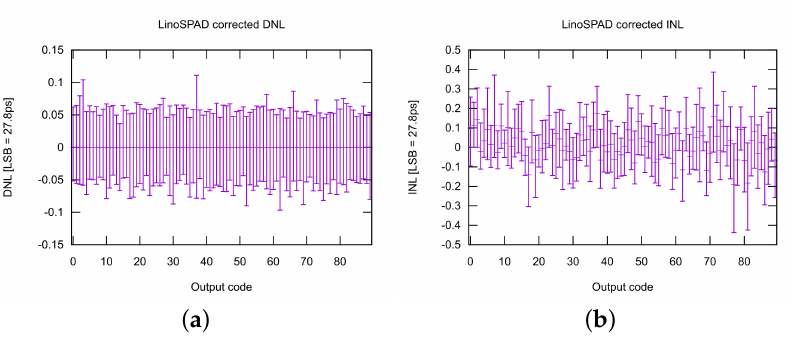
Figure 11. DNL ( a ); and INL ( b ) distributions across all output codes of a TDC when using the correction module after calibration. From 100 sample histograms, the plots show mean, minimum and maximum linearity values. The expected DNL variation from shot noise amounts to roughly 1/3 of the total measured